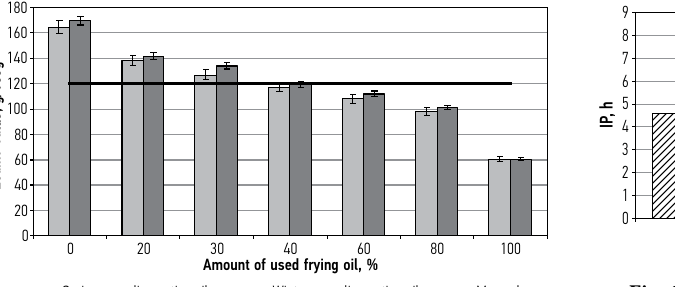
Fig. 2. The dependence of the iodine value on the composition of the mixture of Camelina sativa oil and used for frying oil